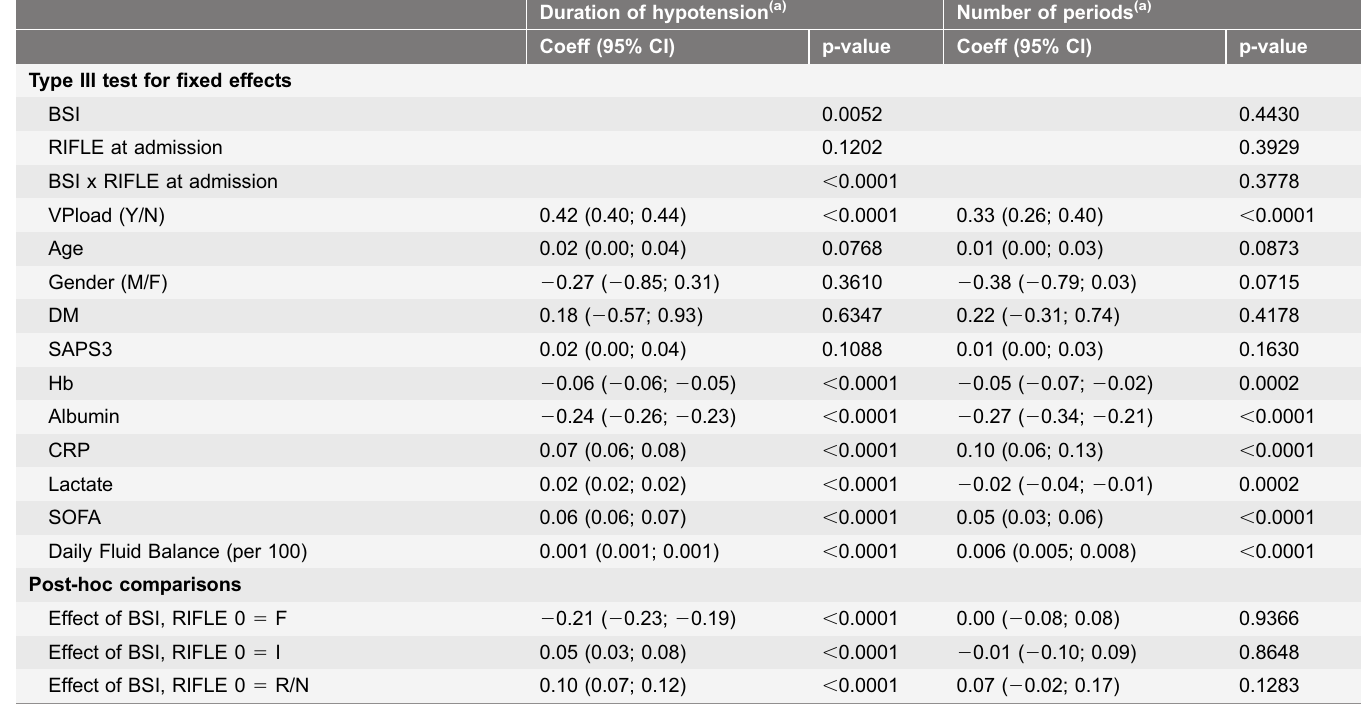
Duration of hypotension